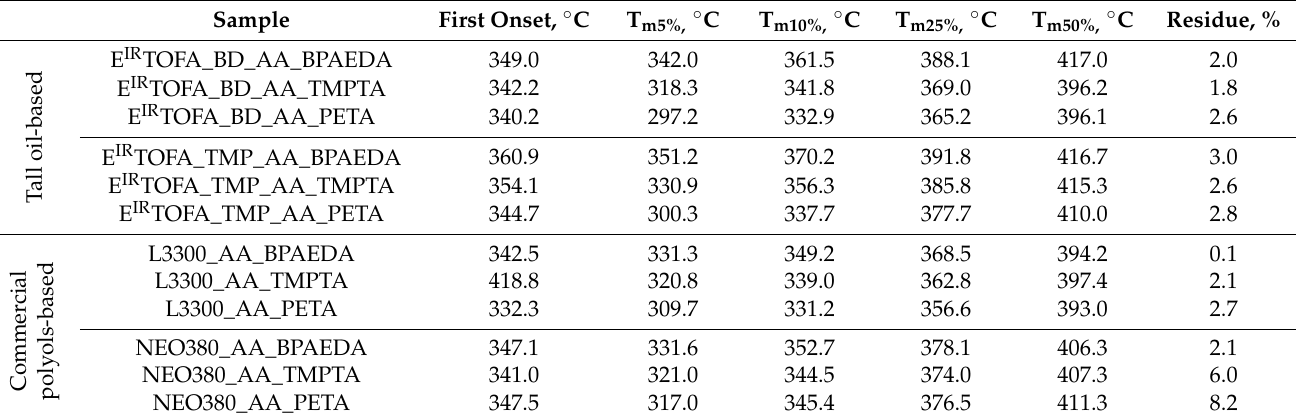
Table 1. Weight loss dependence on temperature of synthesized polymers from tall oil polyol or commercial polyol-based acetoacetates and BPAEDA, TMPTA, and PETA